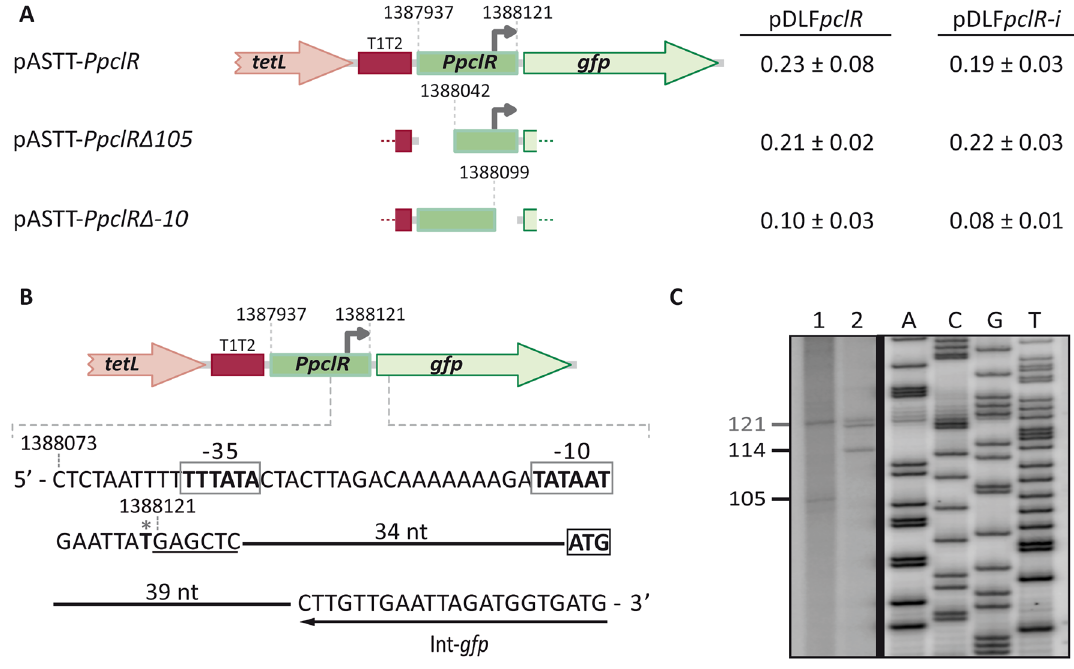
Figure 2. Identification of the PpclR promoter. (A) Fluorescence assays. Three regions of the R6 chromosome were amplified by PCR and inserted into the Sac I site of the promoter-probe vector pASTT. The coordinates of the inserted regions are indicated. The tetL gene confers resistance to tetracycline 33 . The promoter-less gfp gene encodes a variant of the green fluorescent protein 34 . The T1T2 box represents the tandem transcriptional terminators T1 and T2 of the E. coli rrnB ribosomal RNA operon 35 . The grey arrow represents the − 10 element of the PpclR promoter. Each pASTT derivative was introduced into strain R6∆ mga /pDLF pclR (high levels of pclR expression) and strain R6∆ mga /pDLF pclR-i (low levels of pclR expression). The intensity of fluorescence (arbitrary units) corresponds to 0.8 ml of culture (OD 650 = 0.4). In each case, three independent cultures were analysed. (B) Plasmid pASTT- PpclR . The main sequence elements (− 35 box and − 10 box) of the PpclR promoter and the ATG translation start codon of the gfp gene are indicated. The Sac I site is underlined. The position of the Int- gfp oligonucleotide used for primer extension is shown. The asterisk indicates the transcription start site identified in this work. (C) Analysis of primer extension reactions. Lane 1: total RNA from R6/pASTT- PpclR cells and oligonucleotide Int- gfp . Lane 2: total RNA from R6 cells and oligonucleotide Dw 1404 -2. Dideoxy-mediated chain termination sequencing reactions (M13mp18 DNA and primer − 40 M13 36 ) were run in the same gel as DNA size markers. The corresponding lanes (A, C, G, and T) came from the same gel but were taken at a lower exposure (delineation with dividing lines). See the full-length gel (high and low exposures) at the end of the Supplementary Information file. The size (in nucleotides) of the cDNA products is indicated on the left of the